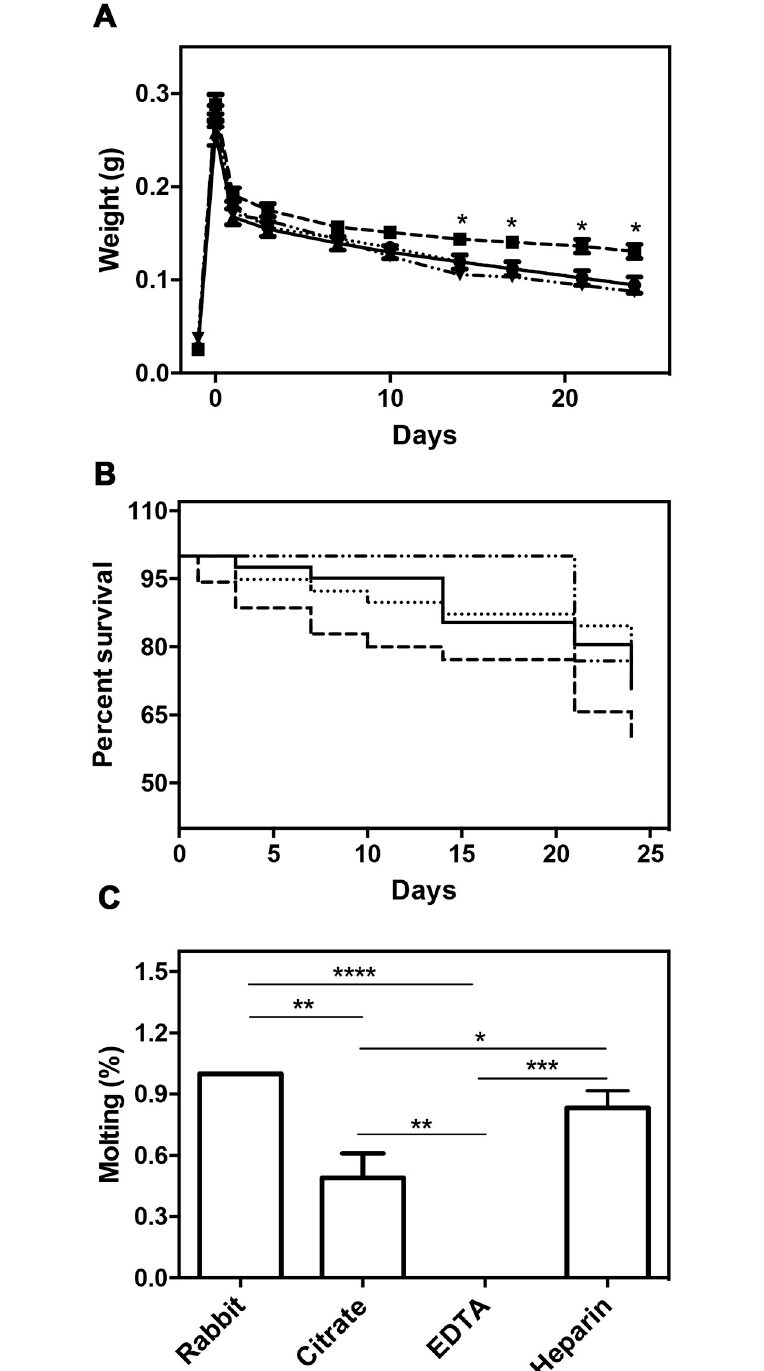
Fig 1. Effects of anticoagulants on blood digestion, survival and molting. The fifth instar nymphs were fed on live rabbit (dotdash line) or on blood collected with citrate (dotted line), EDTA (dashed line), or heparin (continuous line) as anticoagulants. The weight of each insect was measured before and in the following days after feeding them (A), and the number of dead insects was quantified for 24 days (B). On the 24th day after feeding, the percentage of molted insects was calculated (C). Statistical analysis: two-way ANOVA, followed by Bonferroni test (A), total number of insects observed N Rabbit 26, N citrate 39, N EDTA 35, N Heparin 40. Logrank test (B), total number of insects observed N Rabbit 26, N citrate 39, N EDTA 35, N Heparin 40. And one-way ANOVA, followed by Tukey test (C), total number of insects observed N Rabbit 20, N citrate 28, N EDTA 21, N Heparin 27. � P < 0.05; �� P < 0.01; ��� P < 0.001; ���� P <